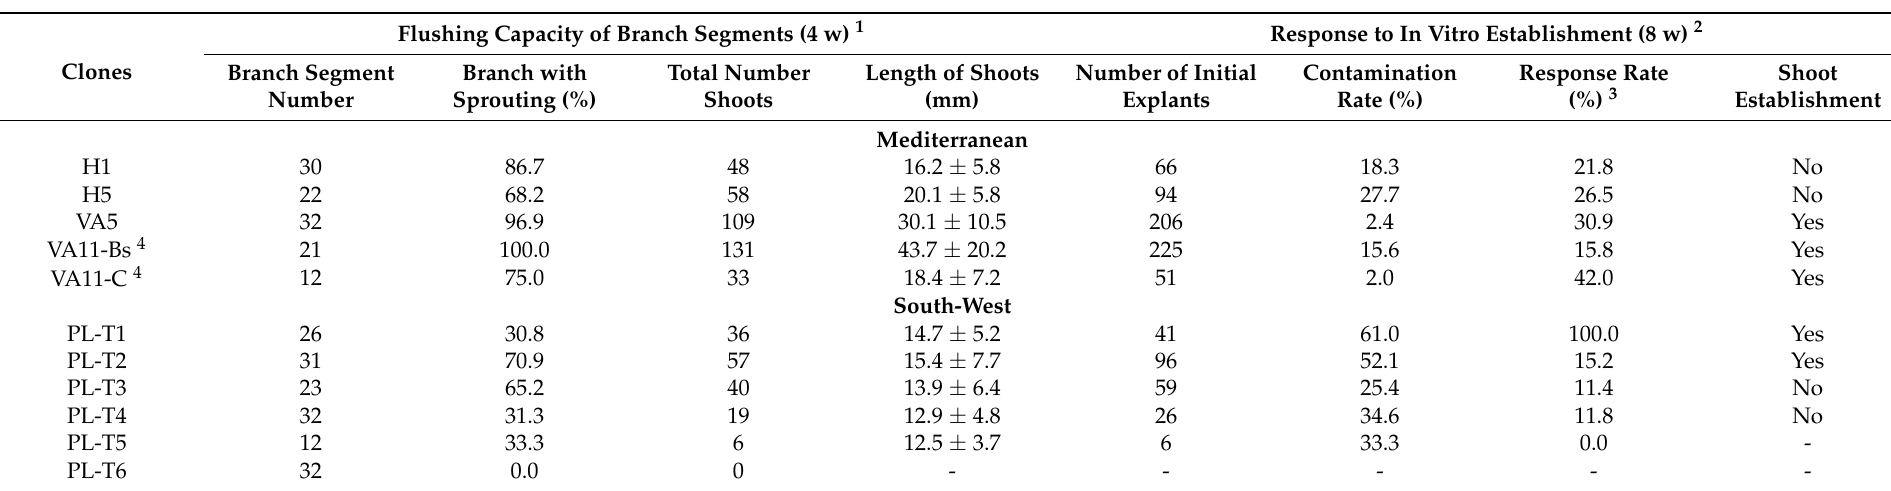
Table 2. Response to sprouting and in vitro establishment of adult oak genotypes from two Spanish regions, Mediterranean and South-west areas.